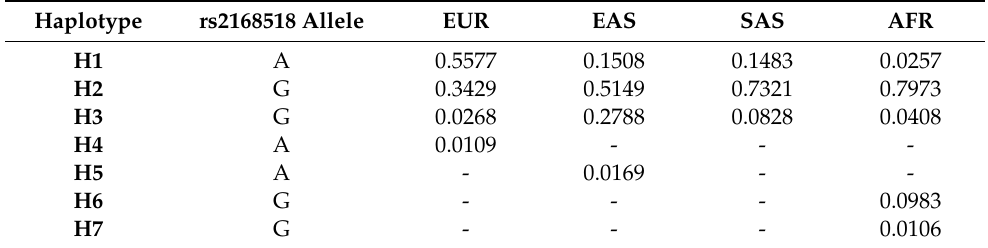
Table 2. Haplotype distribution of genetic variants in LD (R 2 > 0.8 in Europeans) with rs2168518 in di ff erent populations. Haplotype frequencies were calculated with the LDhap tool from LDlink [26,27]. Haplotype rs2168518 Allele EUR EAS SAS AFR H1 A 0.5577 0.1508 0.1483 0.0257 H2 G 0.3429 0.5149 0.7321 0.7973 H3 G 0.0268 0.2788 0.0828 0.0408 H4 A 0.0109 - - - H5 A - 0.0169 - - H6 G - - - 0.0983 H7 G - - -